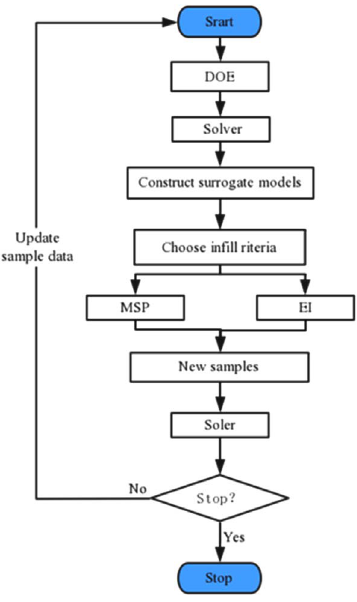
Figure 5. The fl ow chart of the optimization design method of the surrogate model.